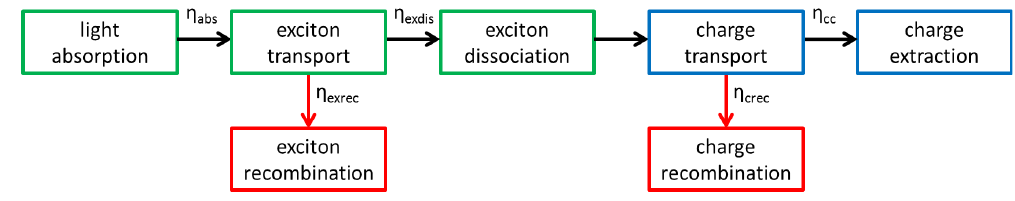
Figure 1. Overview of the photoconversion mechanism in organic solar cells. Processes that involve FRET are indicated in green and recombination pathways in